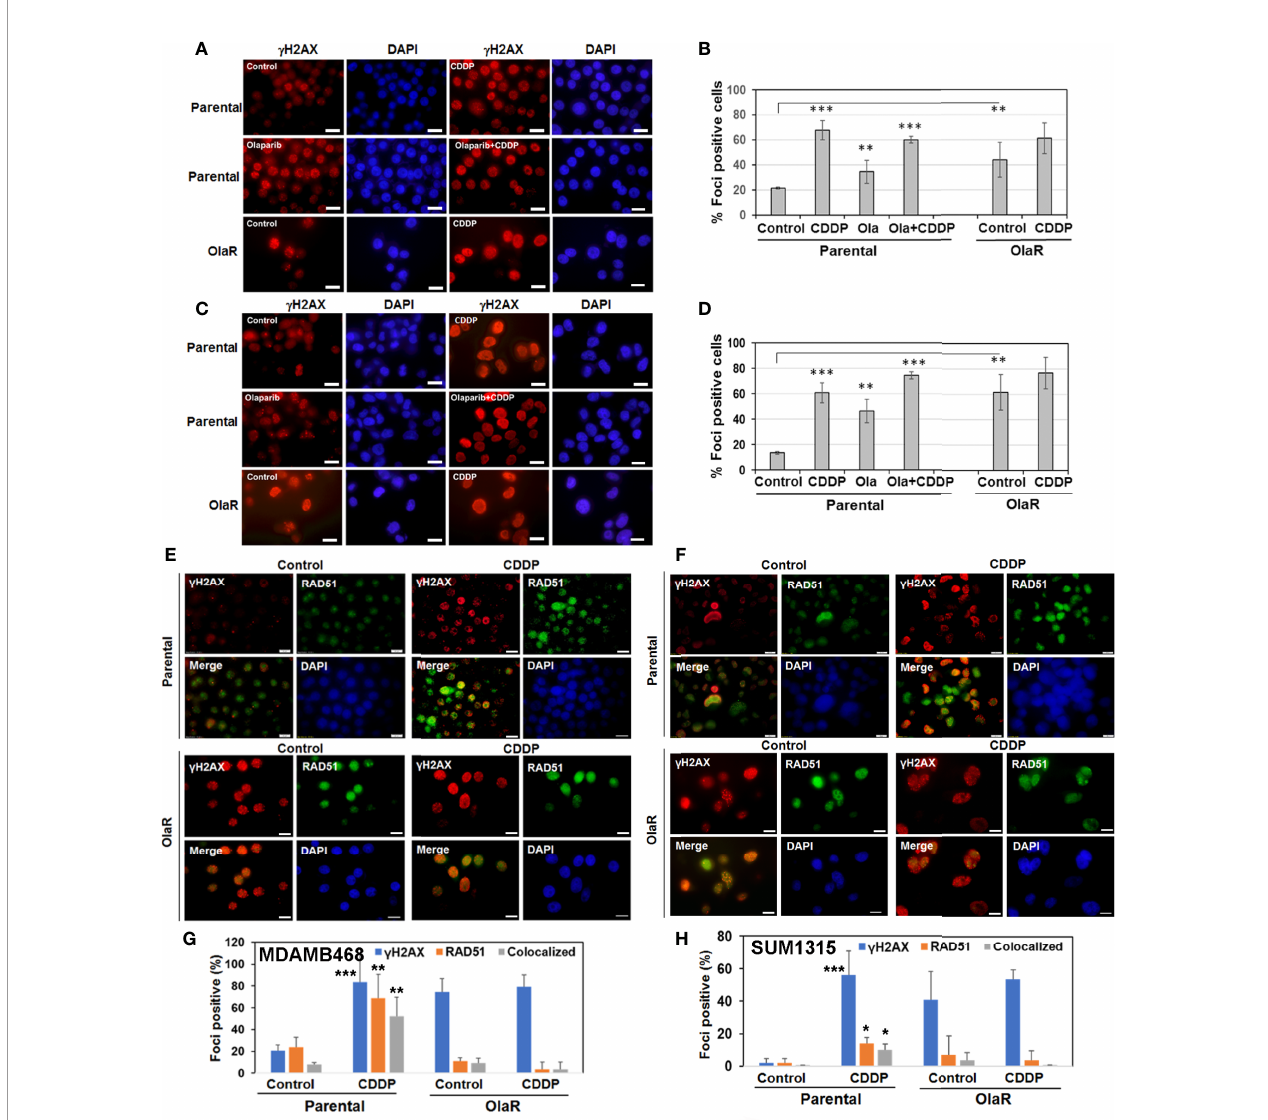
FIGURE 5 | Olaparib resistance impedes Cisplatin (CDDP)-mediated induction of RAD51 foci formation and its colocalization with g H2AX foci in BRCA1 wild type TNBC cells. Immuno fl uorescence staining of g H2AX (A – D) or g H2AX/RAD51 (E – H) foci in parental and OlaR MDA-MB-468 (A, E) or SUM1315 (C, F) cells treated with olaparib, CDDP or olaparib/CDDP combination. Scale bars, 20 m m. (B, D, G, H) Graphs show g H2AX or RAD51 foci positive cells scored from at least 100 cells in fi ve-seven fi elds from two independent experiments by Image J. Results were analyzed by 2-tailed Student ’ s t test and only signi fi cantly affected groups indicated. *P < 0.05, **P < 0.01, ***P <